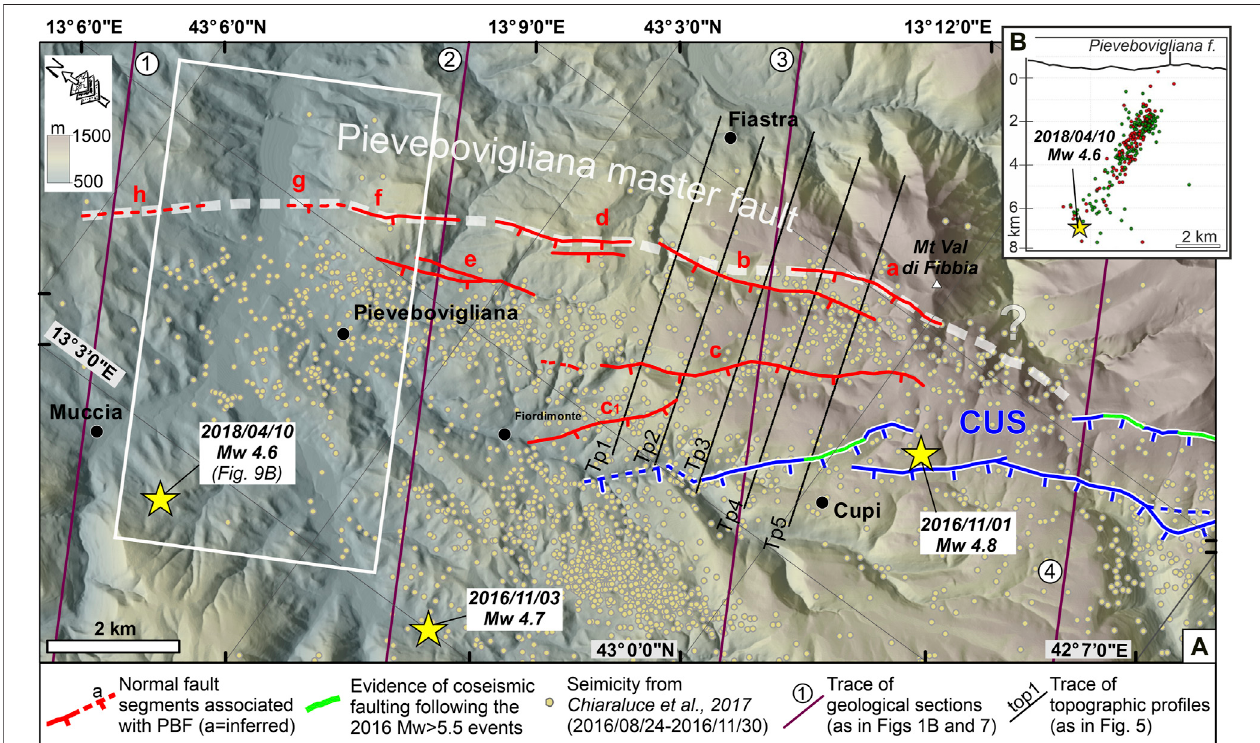
FIGURE9| SummaryofthegeologicalandmorphotectonicevidenceofthePBFwithdetailonitsassociationwiththemainearthquakesthatoccurredinthesector. (A) Map(DEMoverlayingthehillshade)withthenormalfaultsegments(atoh)highlightedinthisstudyandascribedtothePieveboviglianamasterfault(PBF – dashedgray line) activity. Evidence related to each segment is reported in Table 1 . Possible (soft) linkage (question mark label) of the PBF with the CUS (Cupi-Ussita section of the VBF, as in Brozzetti et al. (2019)) is discussed in the text. The epicentral distribution of the seismicity (from Chiaraluce et al. (2017)), as well as the most energetic events(yellowstars)fallinginthesectorand occurredintheperiod 2016 – 2018(M w ≥ 4.5fromScognamiglioetal.(2006)),havebeenalso projectedonthemap. (B) Early aftershock hypocenters for events with M L ≥ 1.0 from high-quality automatic relocations of the 2016 – 2017 Central Italy seismic sequence (Michele et al., 2020), located within the boundary of the white rectangle in map view (see text for details). Key: Green and red hypocenters are the fi rst 72 h after the 26 October (M W 5.9) and 30 October (M W 6.5) major events,